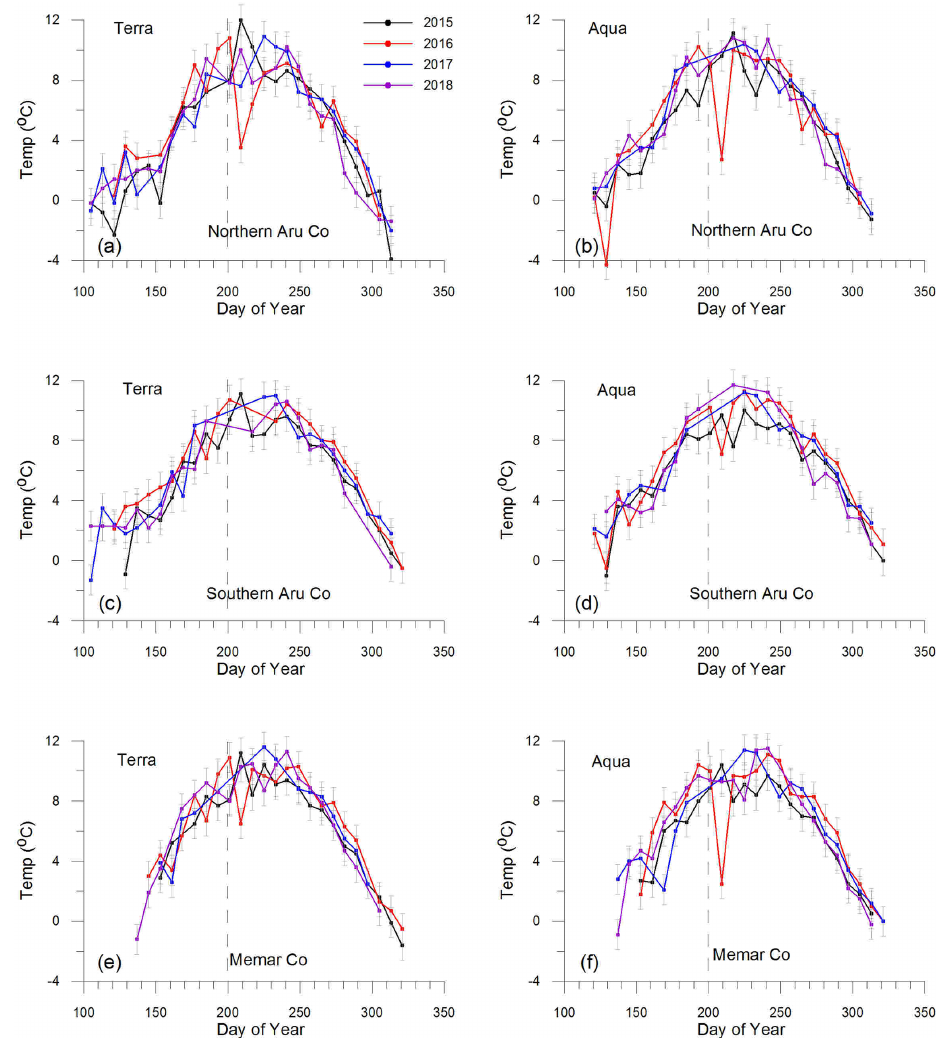
Figure 8. Seasonal changes in nighttime lake surface temperature (LST) derived from Terra MOD11A2 and Aqua MYD11A2 in northern Aru Co (a–b) , southern Aru Co (c–d) and Memar Co (e–f) between 2015 and 2018. The dashed lines indicate the time of the Aru-1 glacier collapse. The error bar is denoted in grey